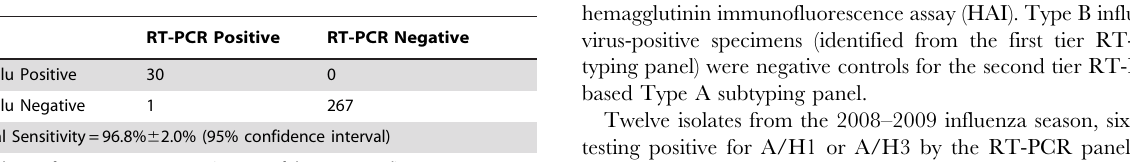
RT-PCR Positive